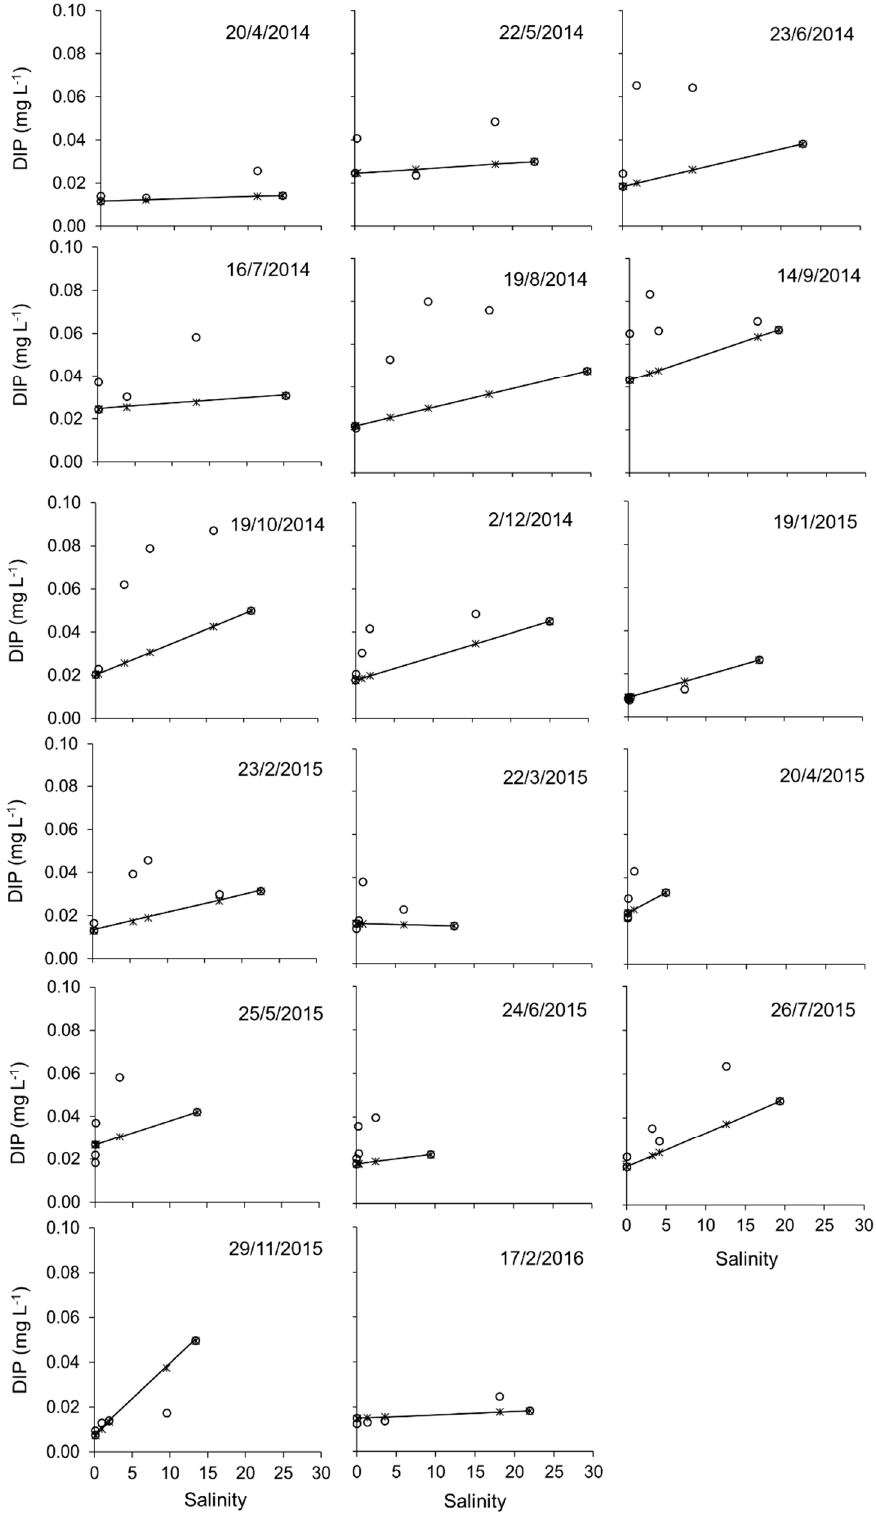
Figure 6. Relationships between DIP and salinity in the Calcasieu River entering the Northern Gulf of Mexico in the southern United States. Hollow circles represent actual measurements. Corresponding conservative mixing values are denoted by stars. Lines represent conservative-mixing models (see Equations (2) and (3)). Site 1 was used as the river endmember, and site 6 was used as the marine endmember.